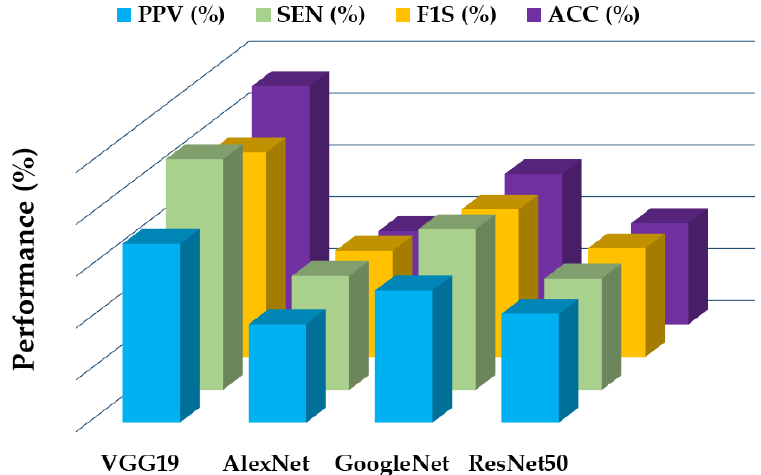
Figure 11. Classification performance comparison of tomato leaf diseases using four different deep- learning network architectures.